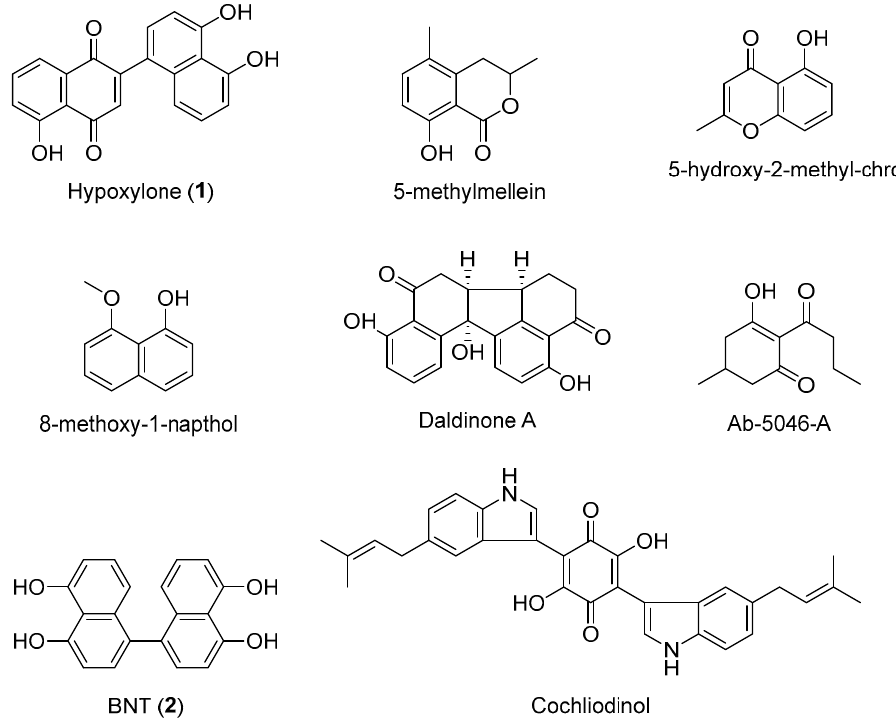
Figure 1. Chemical structures of stromatal metabolites detected in this study as well as representative metabolites from Daldinia , Hypoxylon , and other genera of the Hypoxylaceae as reported by Wendt et al. [3].